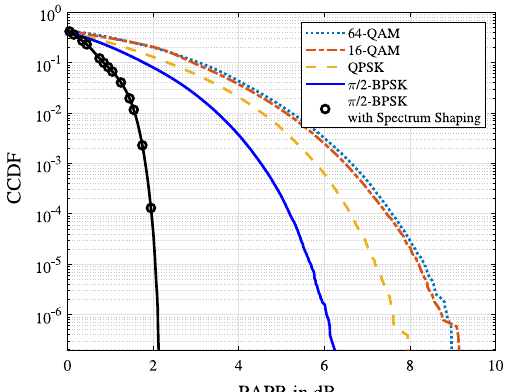
Fig. 6 CCDF of PAPR with various modulation schemes